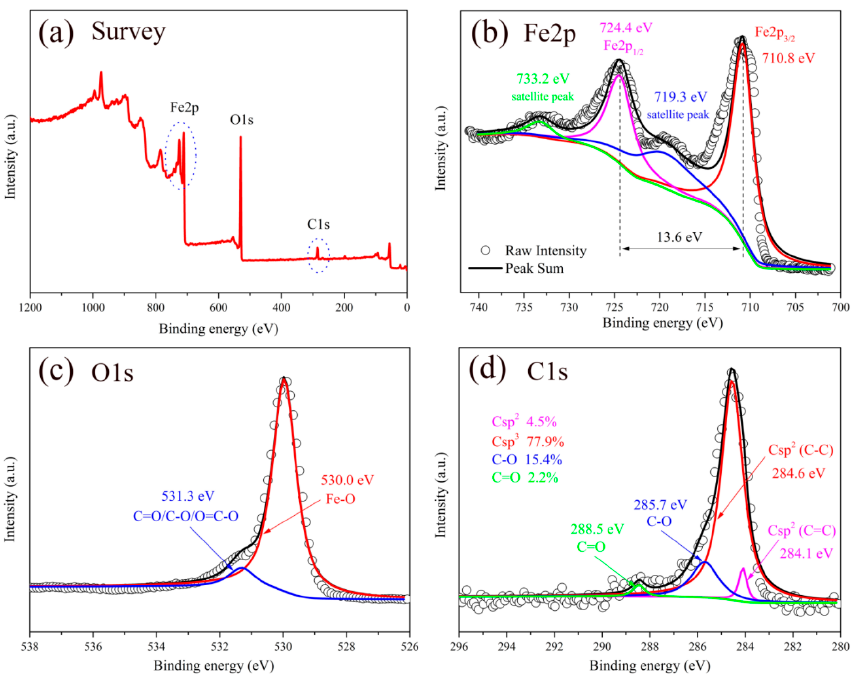
Figure 6. X-Ray photoelectron spectroscopy (XPS) spectrum of α -Fe 2 O 3 @C nanoparticle composite. ( a ) The full-range XPS survey and the high-resolution spectrum of ( b ) Fe2p, ( c ) O1s and ( d ) C1s.